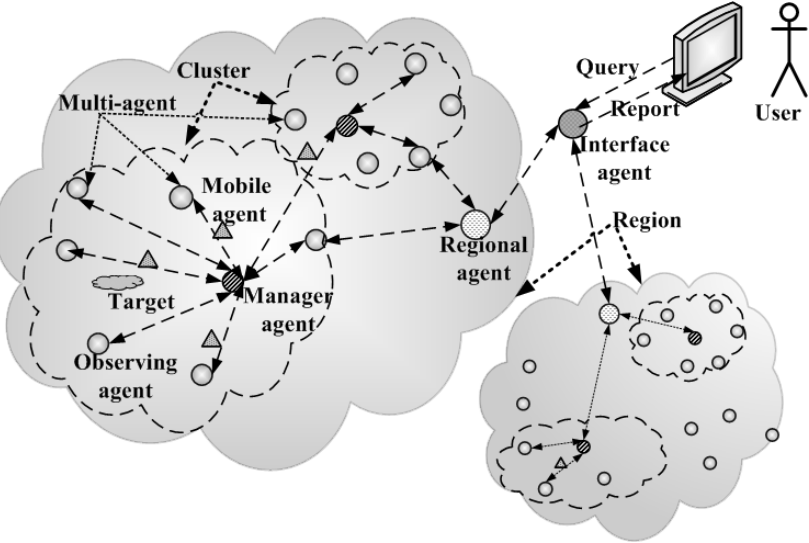
Figure 4. Illustrative WSN deployment with the heterogeneous agent